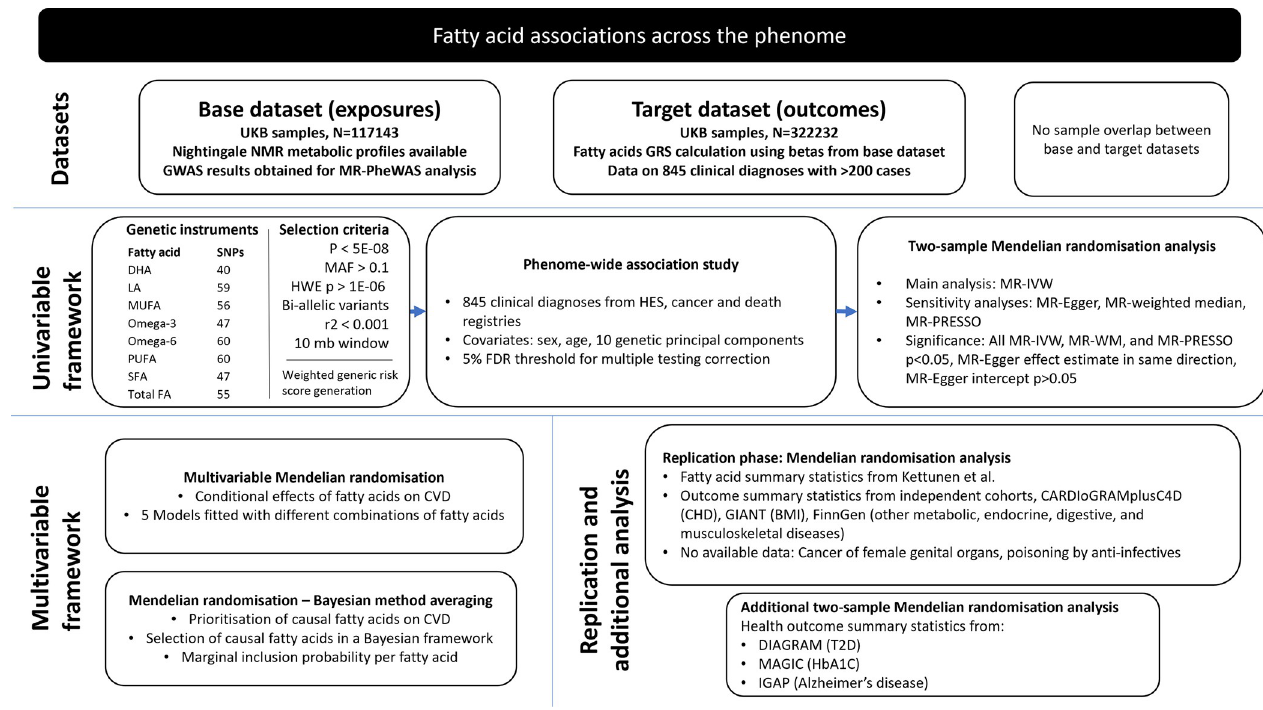
Fig 1. Overview of the study. BMI AU : PleasenotethatabbreviationlistsinFigs 1 (cid:0) 7 havebeenupdated : Pleasecheckandverifythatallentriesarecorrect : , body mass index; CHD, coronary heart disease; CVD, cardiovascular disease; DHA, docosahexaenoic acid; FDR, false discovery rate; GRS, genetic risk score; GWAS, genome-wide association study; HbA1c, haemoglobin A1c; HES, Hospital Episode Statistics; HWE p, Hardy– Weinberg equilibrium p -value; IVW, inverse-variance weighted; LA, linoleic acid; MAF, minor allele frequency; MR-PheWAS, mendelian randomisation– phenome-wide association study; MUFA, monounsaturated fatty acid; NMR, nuclear magnetic resonance; P , p -value; PUFA, polyunsaturated fatty acid; SFA, saturated fatty acid; total FA, total fatty acid; T2D, type 2